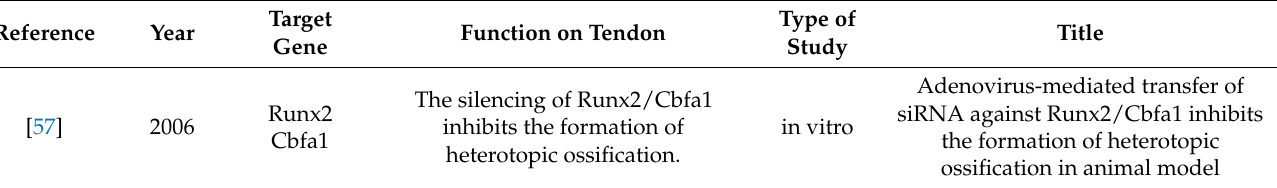
Table 1. siRNAs have been used in tendon healing